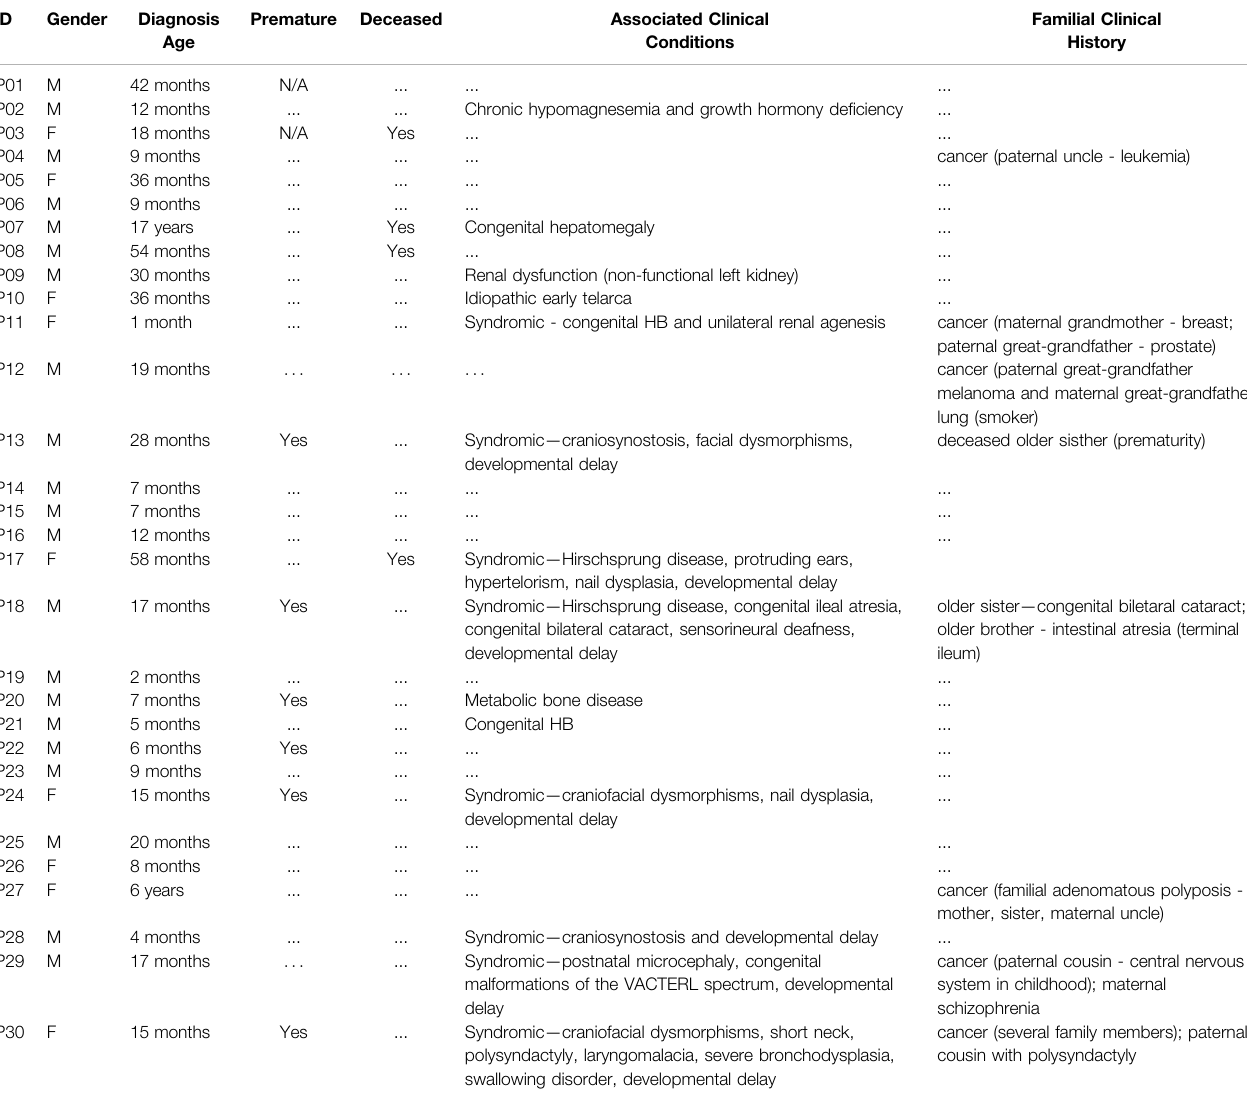
TABLE 1 | Clinical description of the 30 cases of patients who developed hepatoblastoma. ID Gender